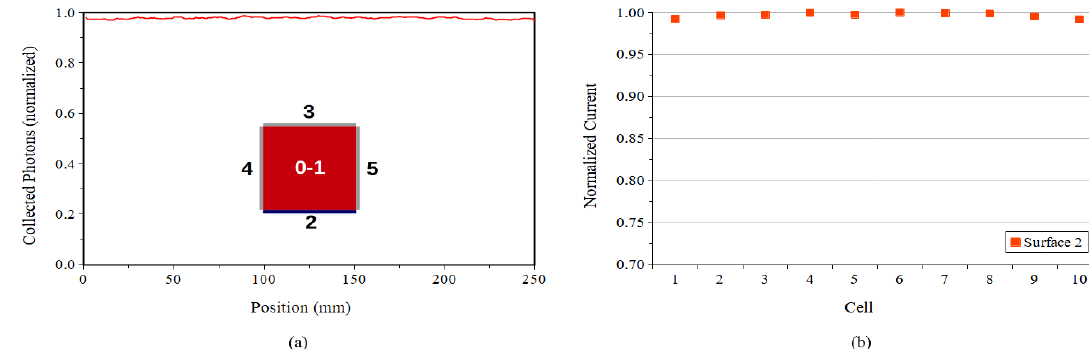
Figure 10. Unshaded LSC panel with one 10-cells PV array: ( a ) Normalized number of rays of light collected by the PV cells as a function the position along the LSC side, which ranges from 0 mm to 250 mm. ( b ) Normalized current produced by each PV cell.